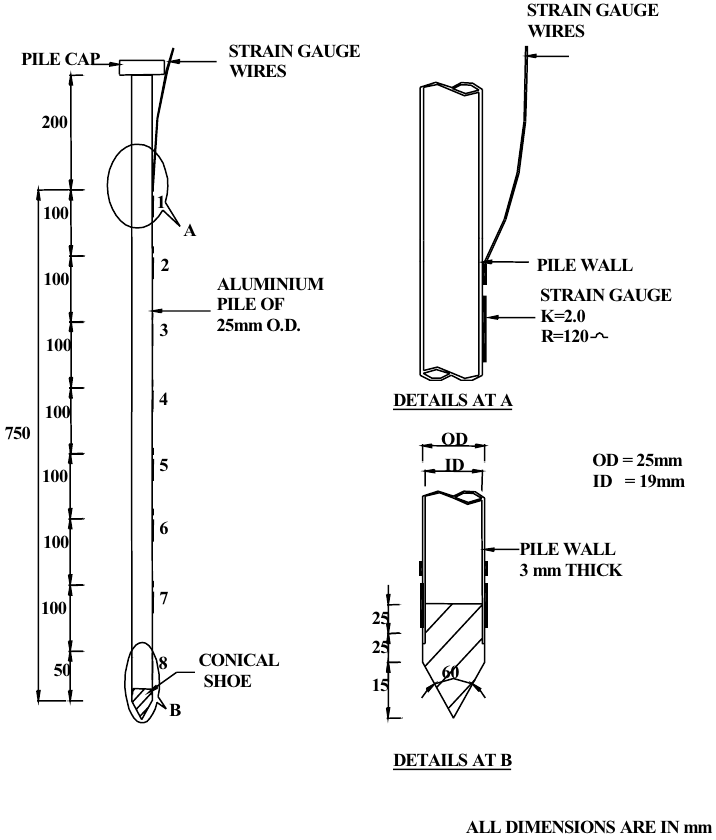
Fig. 1. Instrumented model